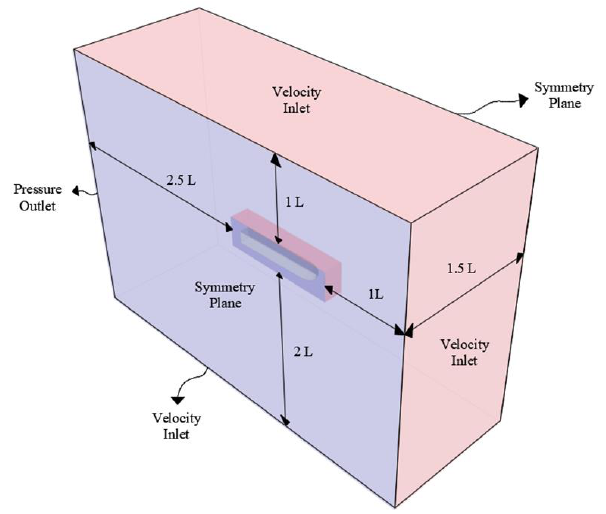
Figure 4. Boundary condition and Fluid domain.